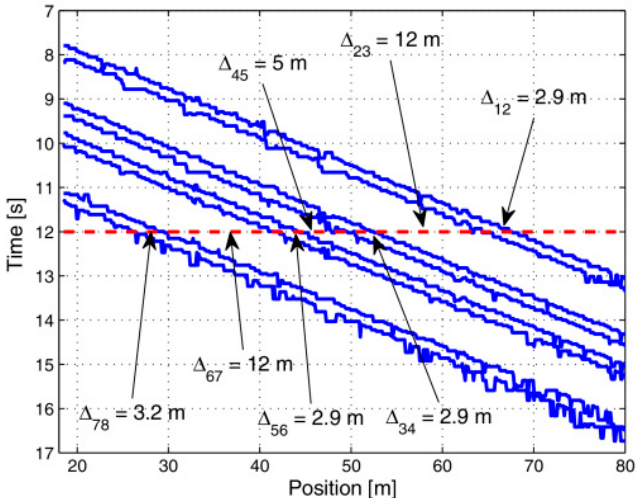
Figure 14. ( a ) Cross-section of the rail, also indicating the position of the glued fiber (red dot), and ( b ) Brillouin gain map as a function of time and position. The superimposed red curve represents the acquired Brillouin frequency shift profile (from Ref. [139]).